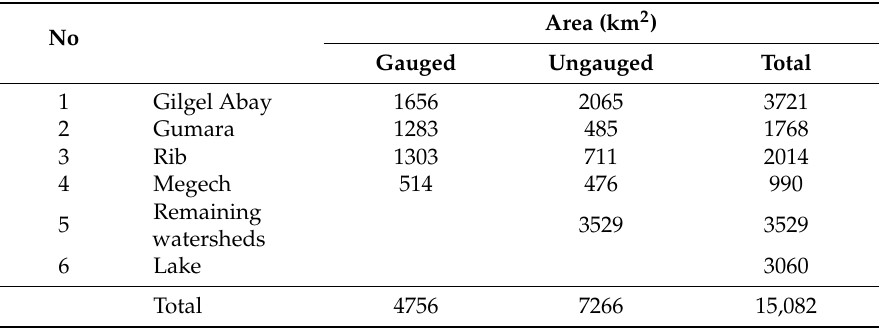
Table 2. The watershed areas of the four main rivers in the Lake Tana basin for the upper gauged part and the lower ungauged part, the area for the remaining ungauged watersheds that are drained by smaller rivers and area of Lake Tana.